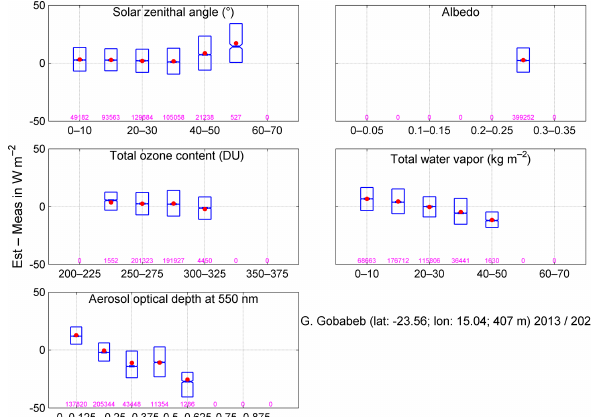
Figure 4. Box plots of the differences between the McClear esti- mates and the measurements of G at the BSRN station Gobabeb (no. 28, climate BWh) for several classes of various variables. In each box plot, the red point is the mean while the lower, middle, and upper lines are respectively the 25th, 50th, and 75th percentiles. The number of samples is given for each class. Only classes with at least 50 samples are drawn.